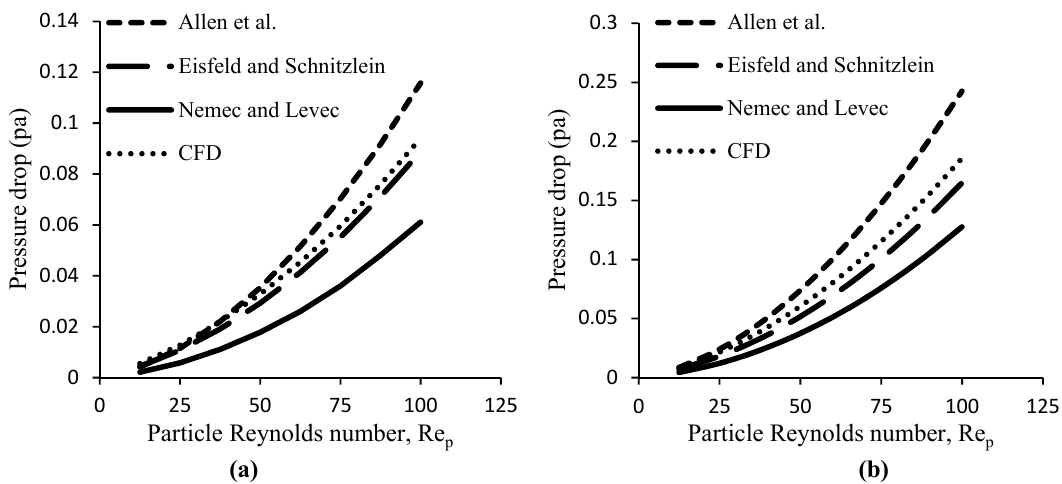
Fig. 6. Comparison of CFD pressure drop with empirical correlations for the packed bed with cone particles in laminar flow: a) N=5.24 and b) N=11.8.